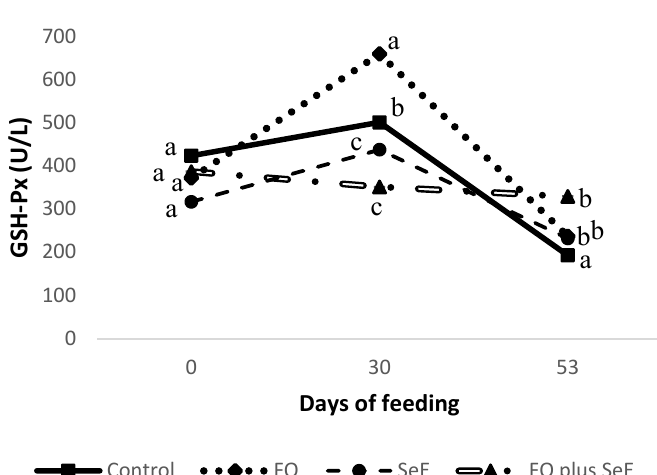
Figure 1. Plasma glutathione peroxidase (GSH-Px) activity obtained for the different treatments according to days of feeding; a–c—treatments in the same time point, followed by different lowercase letters, differ significantly at the 5% level.